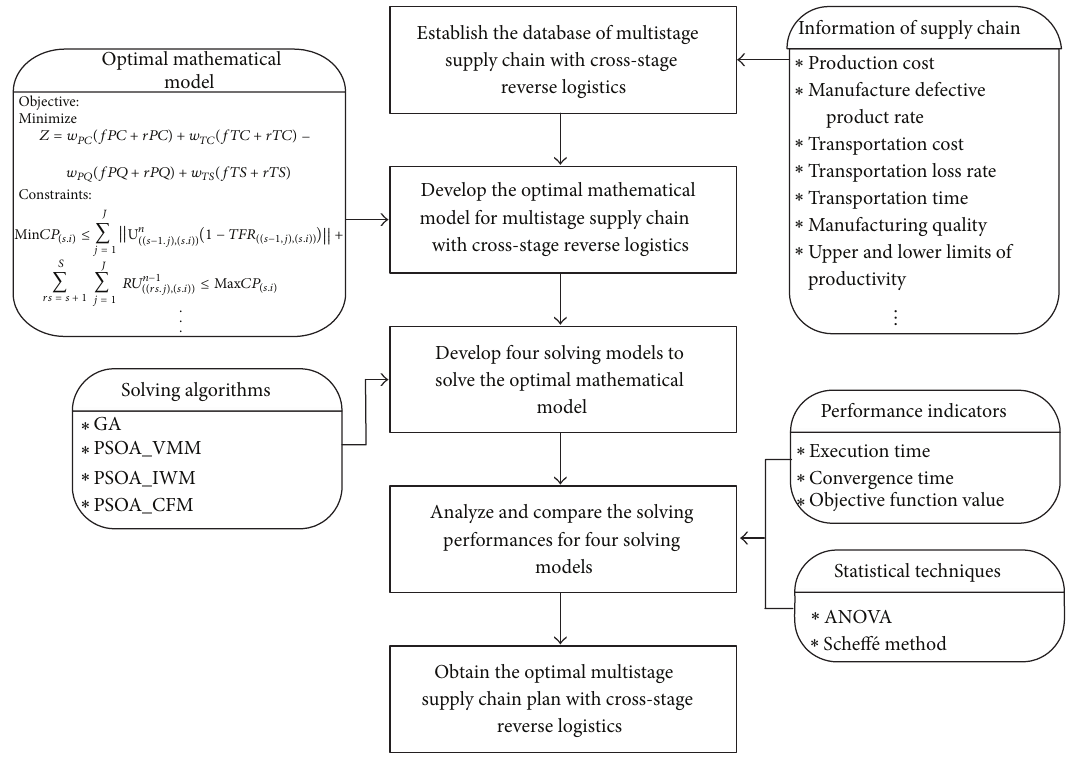
Figure 3: The structure of this